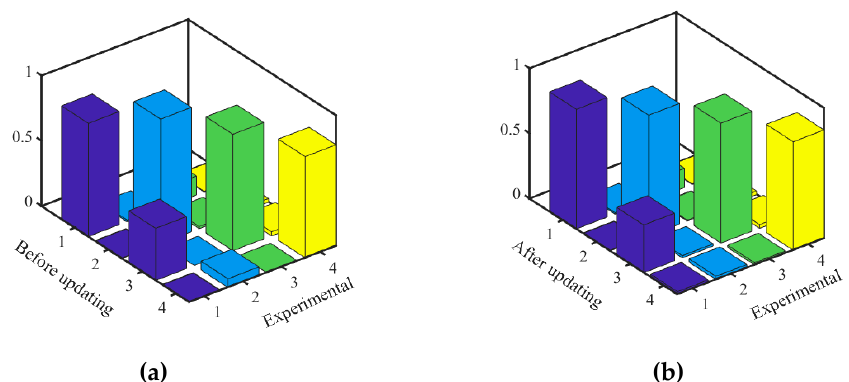
Figure 18. Comparison of MAC before and after model updating: ( a ) Before updating; ( b ) After updating.